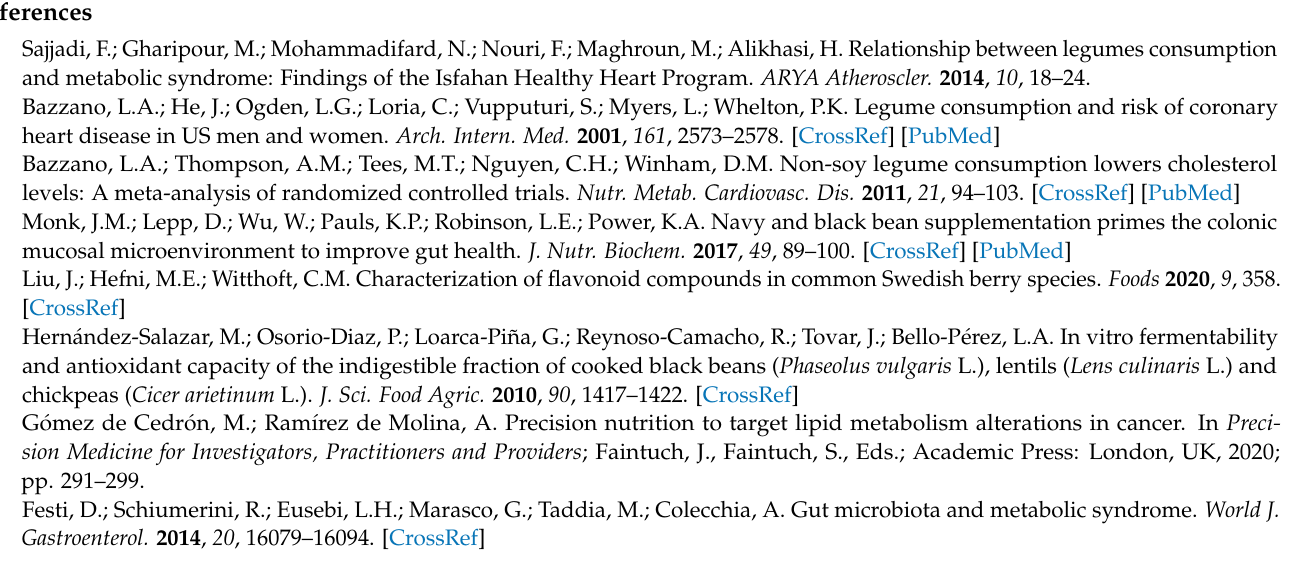
Table S2: Nutritional content and main flavonoids in the cooked whole brown bean (Wbean) and the isolated dietary fiber fraction (Bfiber); Figure S1: Monomeric composition (%) of total dietary fiber polysaccharides in cooked brown bean containing 27 g/100 g fiber on a dry weight basis; Figure S2: (A) Body weight gain, (B) cumulative diet consumption, (C) ratios of liver to body weight, (D) ratio of cecum to body weight, and (E) ratio of fat pads to body weight in mice fed a low fat (LF), high fat (HF), whole brown bean (Wbean), or bean fiber (Bfiber) diet for 10.5 weeks; Figure S3: Cecal proportions (%) of (A) acetic acid, (B) propionic acid, (C) butyric acid, and (D) minor acids in Apoe − / − mice fed a control diet (low fat (LF) or high fat (HF)) or a bean diet (whole brown bean (Wbean), bean fiber (Bfiber)) in an HF setting for 10.5 weeks; Figure S4: Principal component analysis (PCA) biplot based on (A) organ and body weight and biomarkers and (B) bacteria obtained from mice fed a low fat (LF), high fat (HF), whole brown bean (Wbean), or bean fiber (Bfiber) diet for 10.5